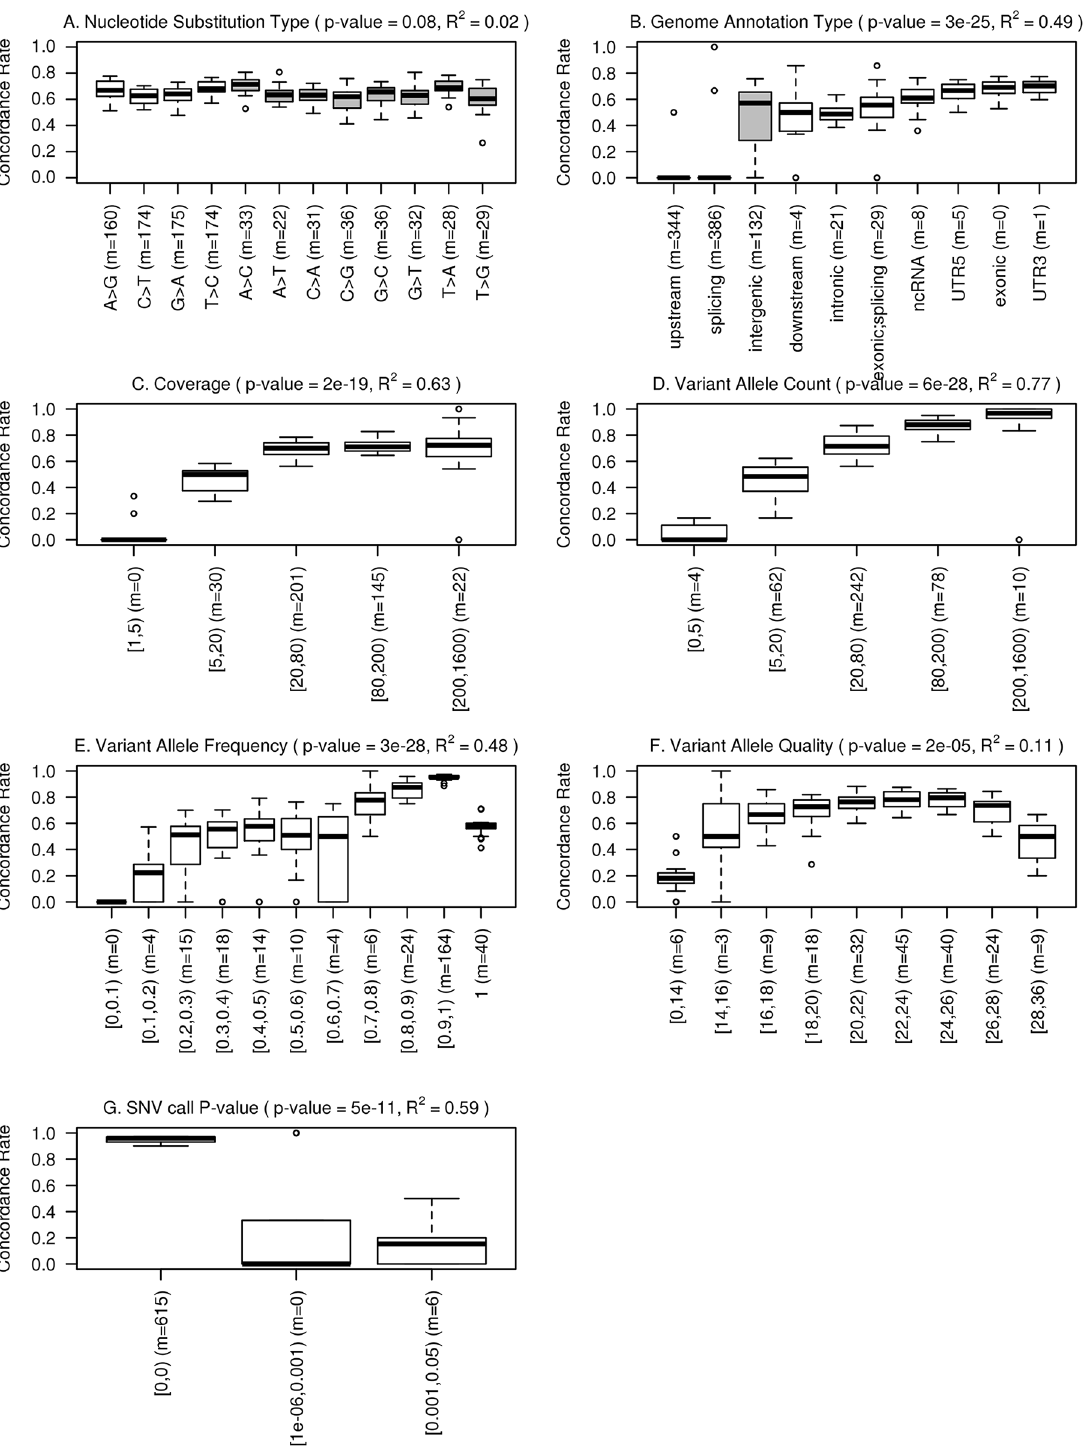
Fig 3. Boxplots of SNV call concordance between replicated samples by different factors, including (A)_nucleotide substitution type (gray-shaded boxes = transversions, open boxes = transitions), (B) genome annotation type, (C) coverage, (D) variant allele account, (E) variant allele frequency, (F) variant allele quality, and (G)) SNV call p-value. The numbers in parenthesis (m) represents the median of the numbers of SNVs per replicated sample that were counted in a given category. ANOVA test p-values are shown. Coefficient of determination (R 2 ), indicating the proportion of the total variation of concordance rate that is explained by the factor alone, is shown for each